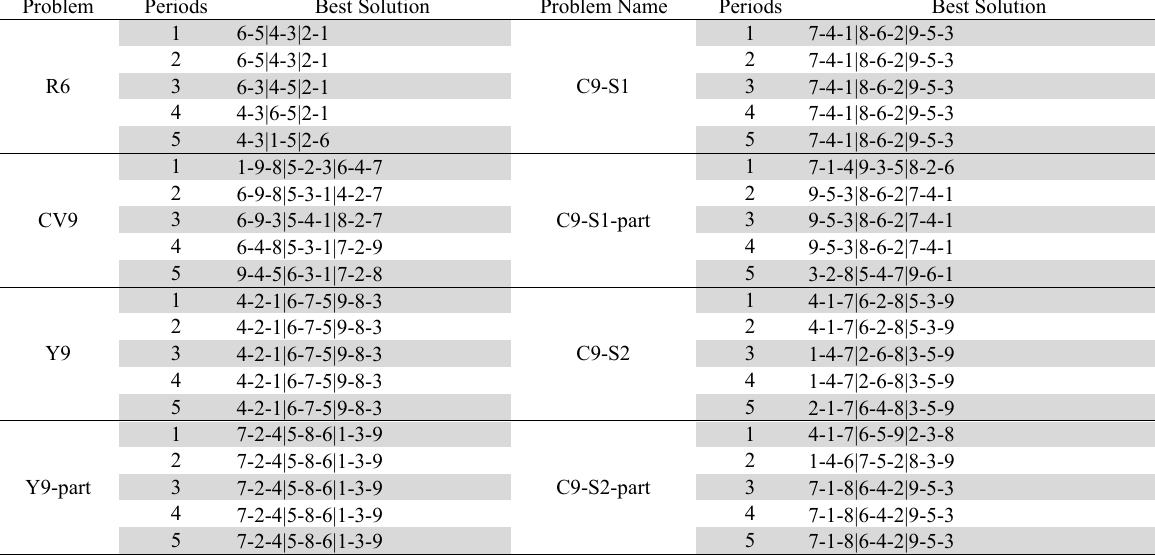
Best solution found by the proposed SA heuristic for equal area DFLP data set